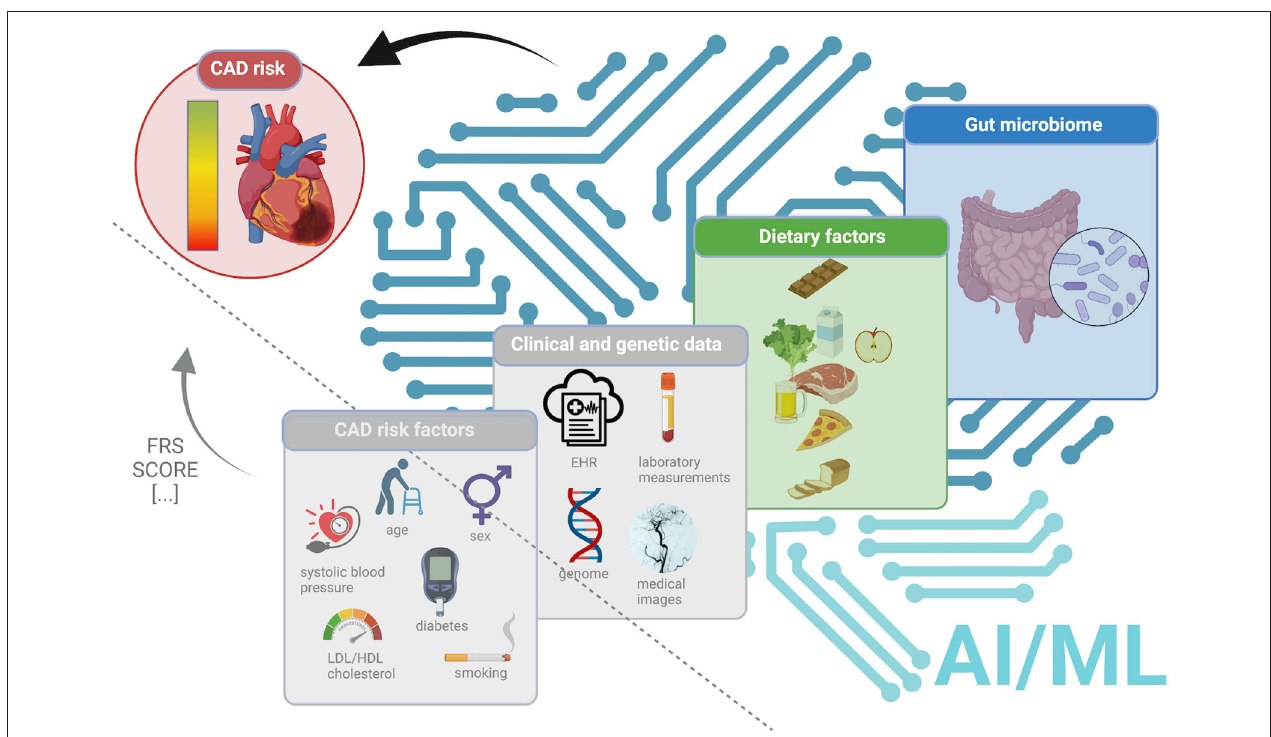
FIGURE 1 | An overview of the current status and future directions to improve CAD risk prediction. The left panel (triangle separated by a dashed line) demonstrates the current status (in gray, as not explicitly considered in this Mini-Review), demonstrates the current metrics such as FRS ( Wilson et al., 1998) or SCORE (Conroy et al., 2003) using the traditional CAD risk factors (age, sex, diabetes, systolic blood pressure, LDL/HDL cholesterol, smoking). The right panel (separated by a dashed line) highlights the possible future directions to improve CAD risk prediction using AI/ML approaches and, alongside with clinical data and genetic variations (in gray, as not explicitly considered in this Mini-Review) dietary factors (in green) and/or gut microbiome (in